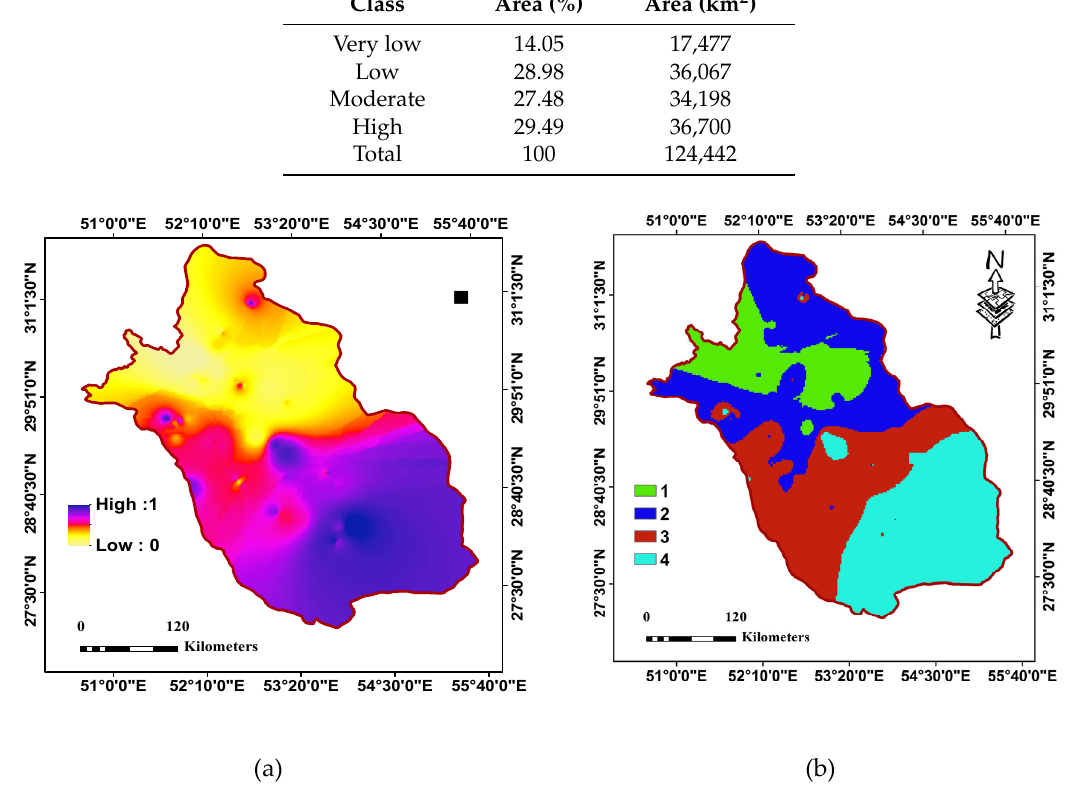
Figure 5. The KSP maps for the studied region as determined by fuzzy and analytical hierarchy process (AHP) ( a ) KSP map ( b ) reclassified map of KSP map.